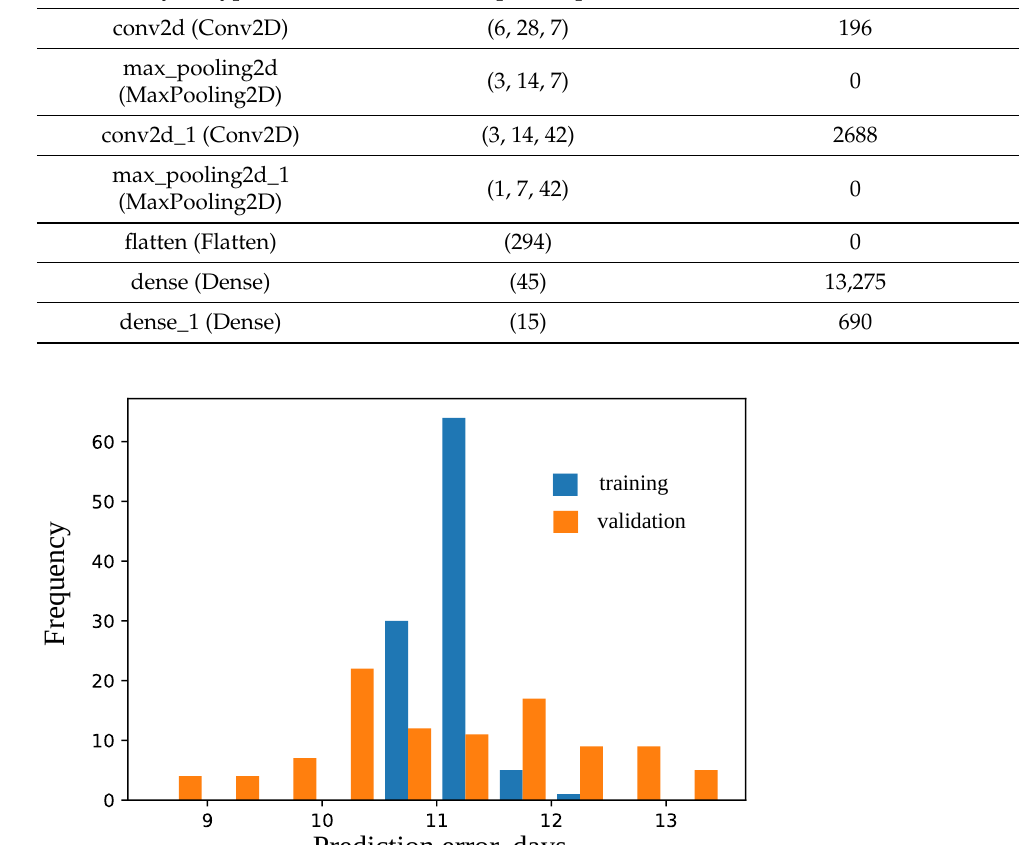
Figure 8. Histogram of errors in days for training and validation sets for models for the union SNP set. Mean values are 10.893 and 10.905, respectively.